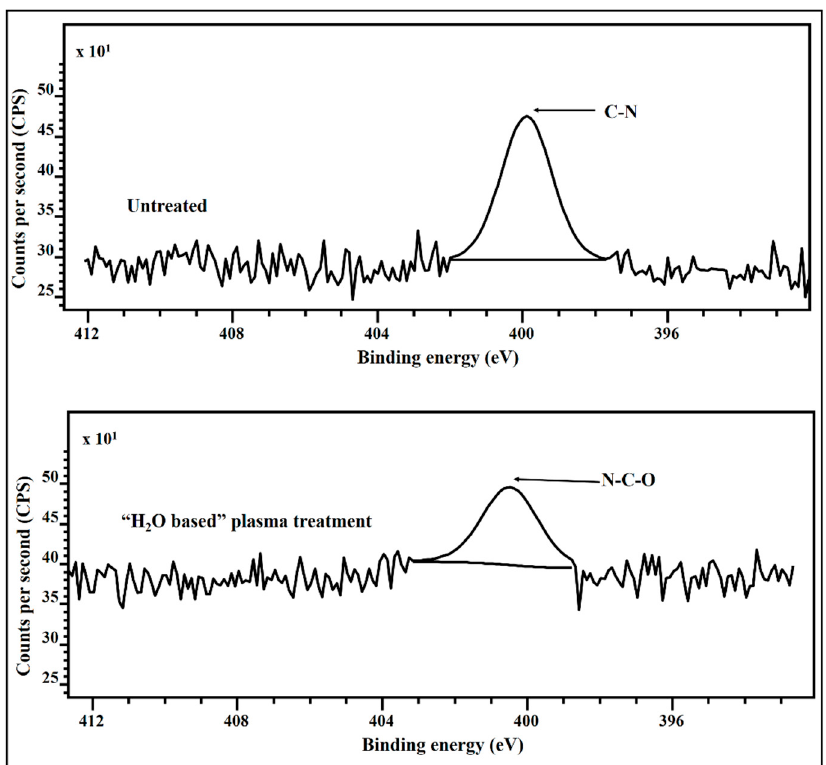
Figure 9. Component fitting of high-resolution N1s spectra of untreated and 10 s H 2 O-LPP-treated Bambara groundnut seeds.